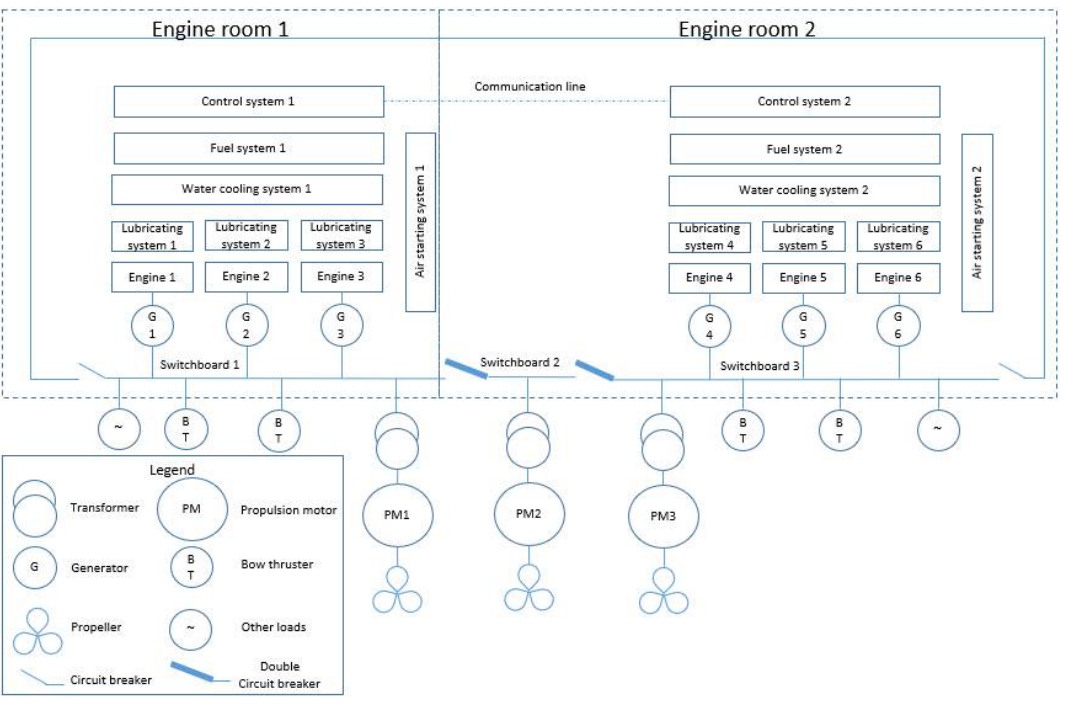
Figure 2. Cruise ship propulsion system layout adopted from